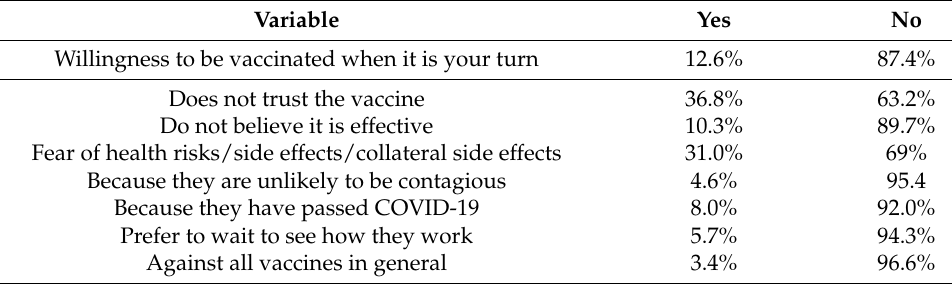
Table 4. Analysis of the group detected as the most